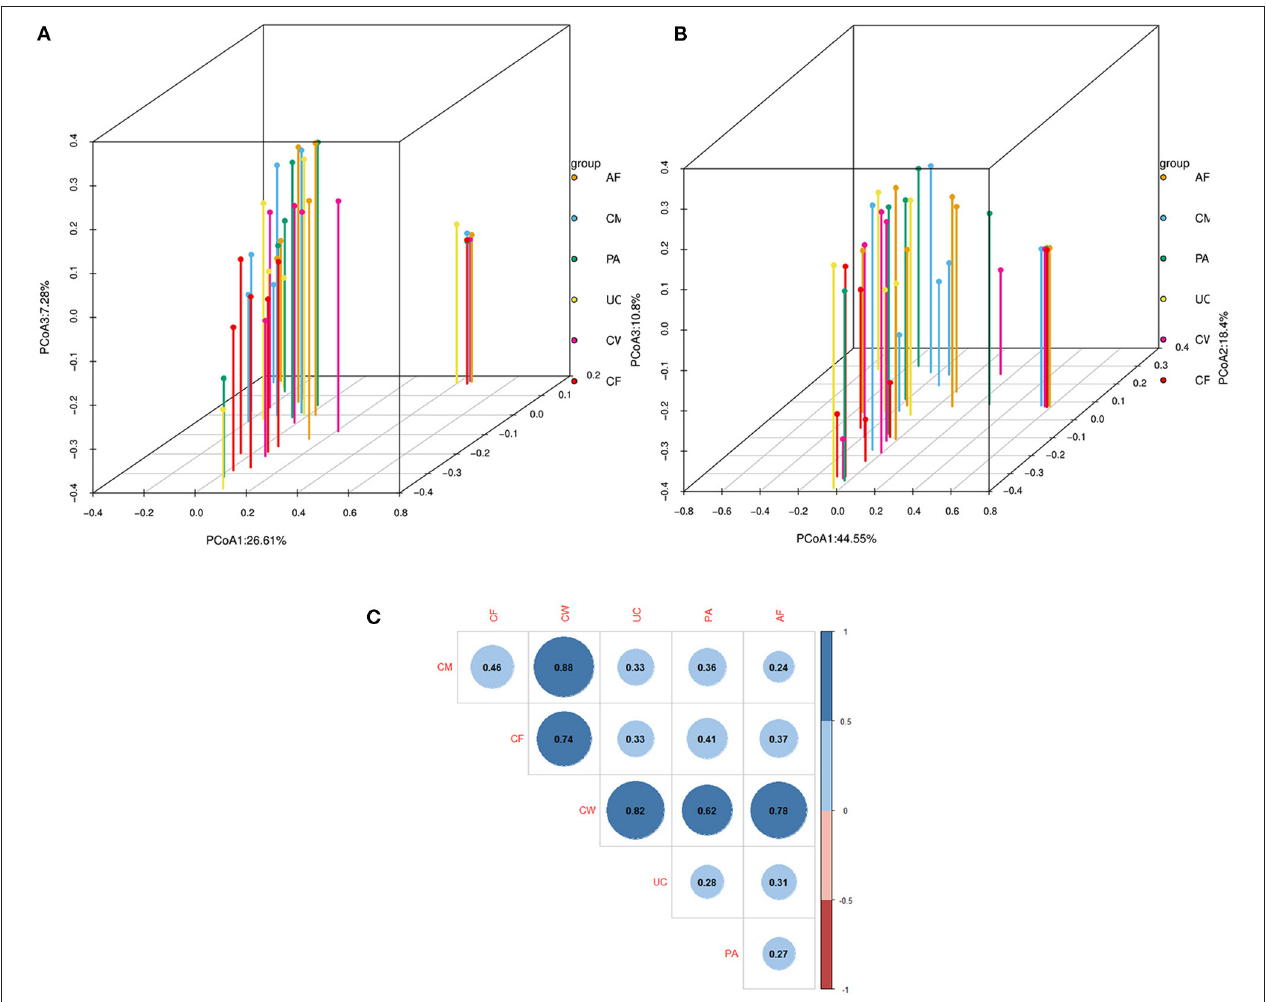
FIGURE 2 | Dissimilarity-based multivariate analyses of microbiome communities of different sample types. Score 3D plots of principal coordinates analysis (PCoA) of different microbiome communities based on (A) weighted and (B) unweighted UniFrac distances. (C) Bray-Curtis dissimilarity matrix calculated based on microbial abundance patterns of operational taxonomic units (OTUs) of different sample types (Blue: positive, red: negative. The larger the absolute value is, the larger the area of the circle). The smaller the value of different degree indexes is, the higher the similarity (i.e., the difference between samples). AF, cow amniotic fluid; CF,